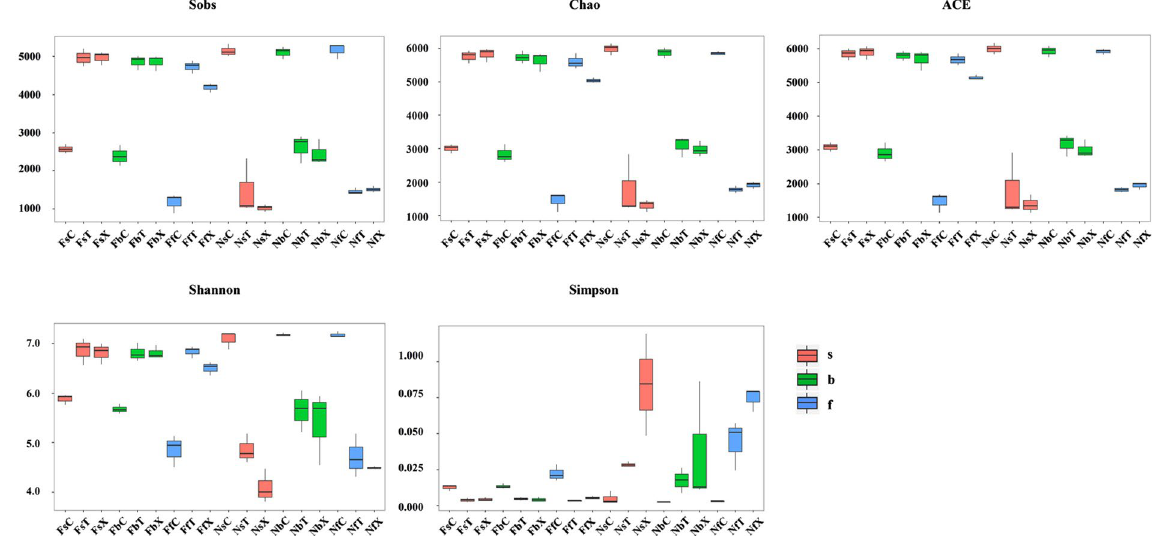
Figure 4. Bacterial α -diversity in each sample. From left to right and from top to bottom, box plots are Sobs, Chao, ACE, Shannon, and Simpson indices.